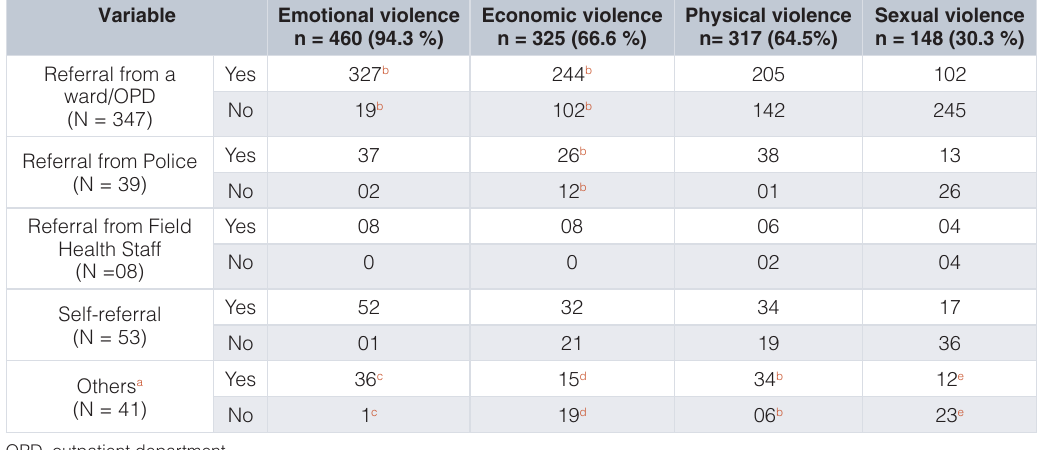
Table 3. Modes of referral and types of gender-based violence